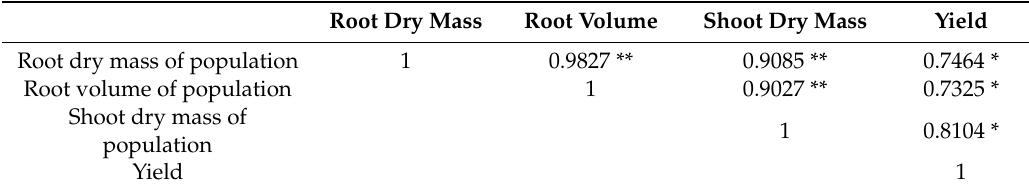
Table 8. Pearson correlation coe ffi cients between grain yield and root / shoot systems (pre-tasseling). Root Dry Mass Root Volume Shoot Dry Mass Yield Root dry mass of